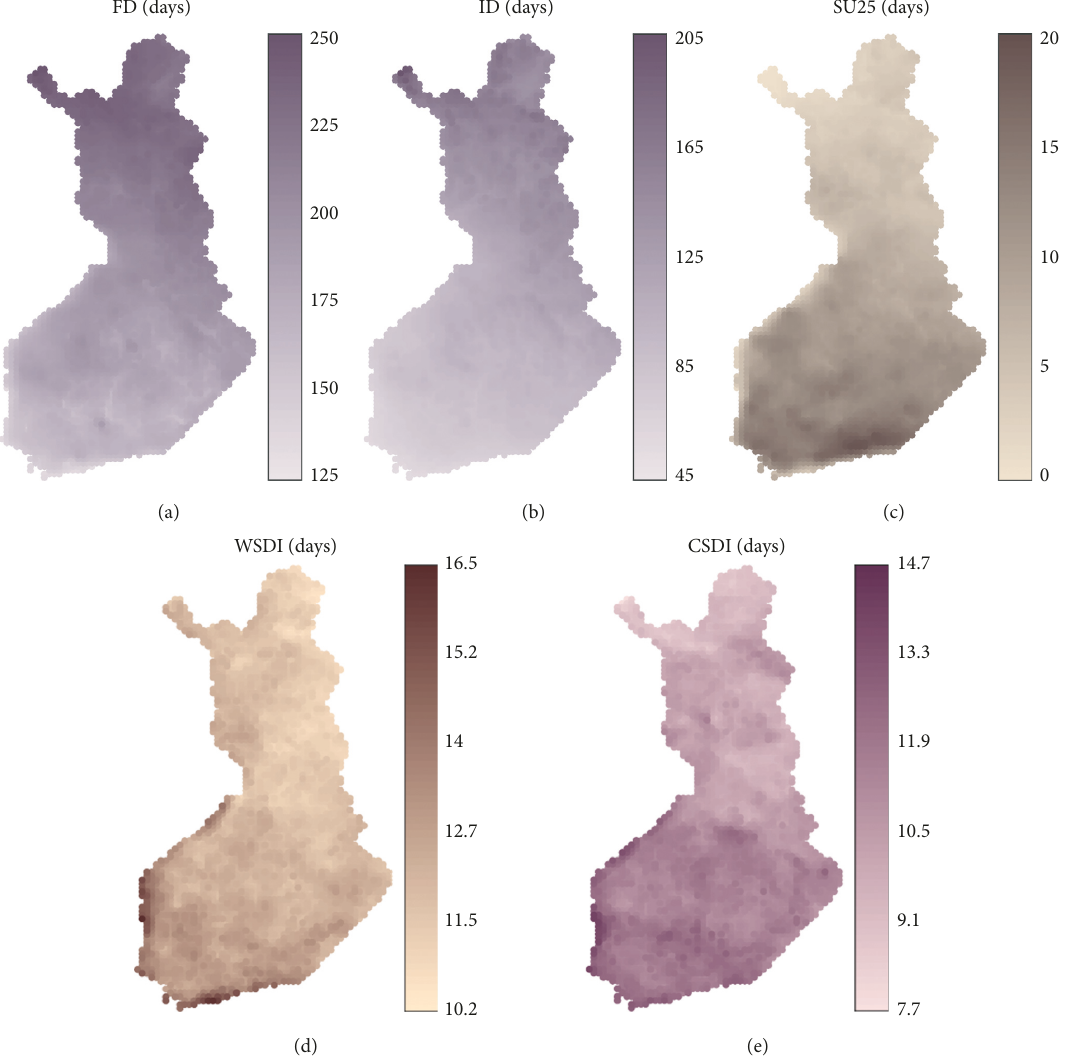
Figure 5: Spatial distribution maps of base values for (a) FD, (b) ID, (c) SU25, (d) WSDI, and (e) CSDI in Finland during